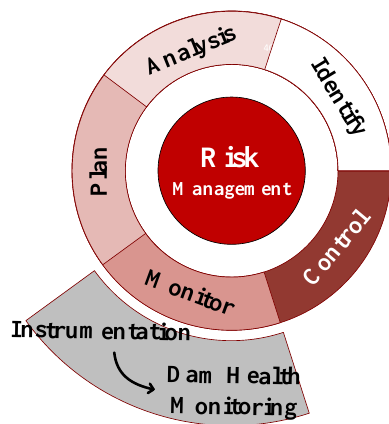
Figure 1. Interconnection of risk management with dam health monitoring and